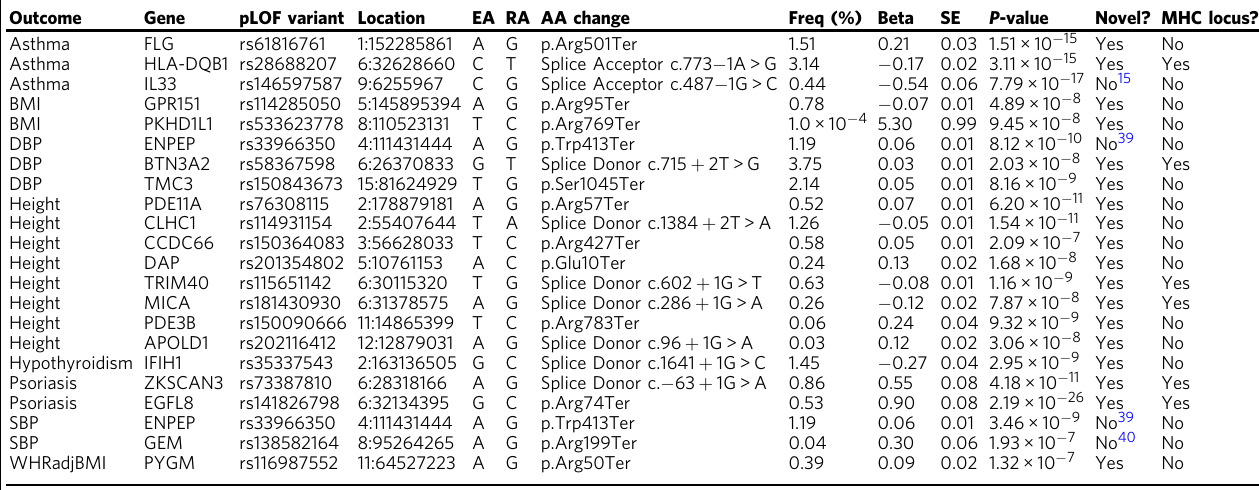
Beta in terms of standard deviations and reported for the effect allele pLOF predicted loss-of-function, EA effect allele, RA reference allele, AA Change amino acid change, Freq(%) Frequency(%); BMI body mass index, DBP diastolic blood pressure, SBP systolic blood pressure, WHRadjBMI waist-to-hip ratio adjusted for body mass